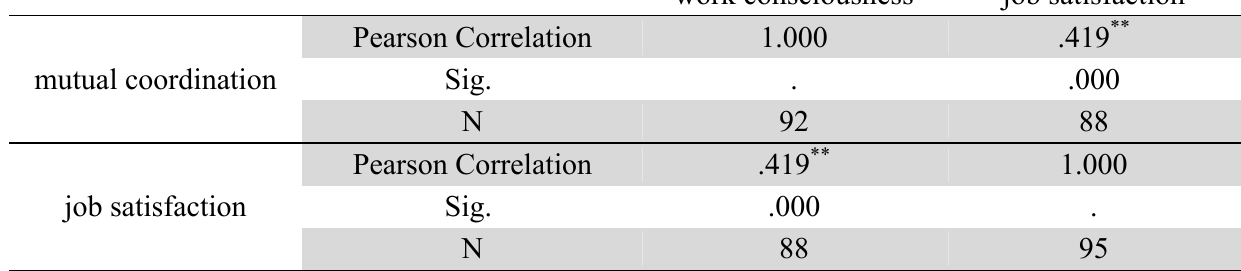
The relationship between mutual coordination and job satisfaction work consciousness job satisfaction Pearson Correlation 1.000 .419 ** mutual coordination Sig. . .000 N 92 88 Pearson Correlation .419 ** 1.000 job satisfaction Sig. .000 . 95